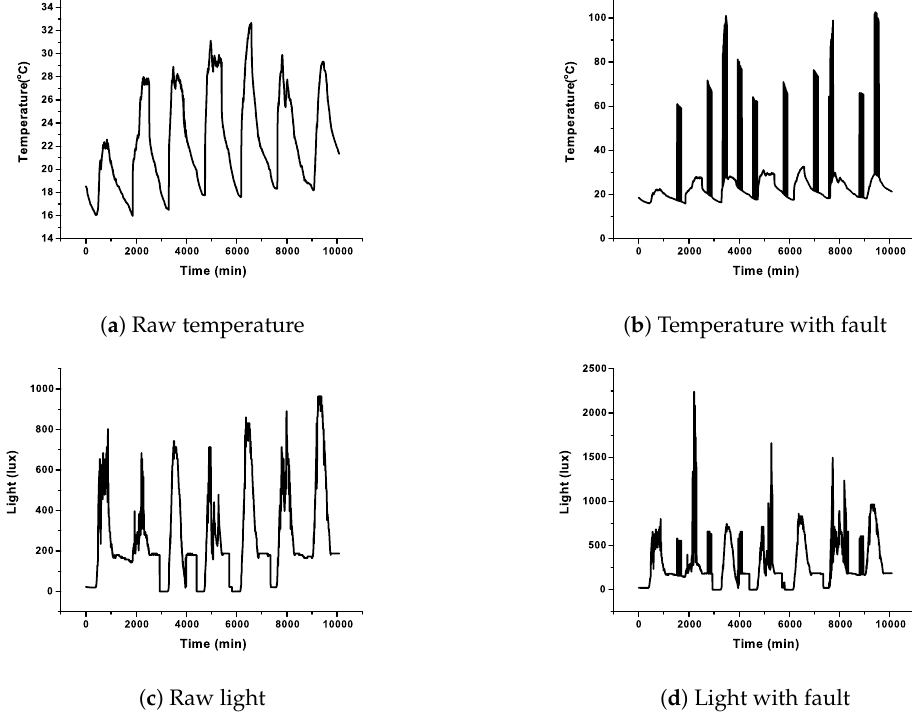
Figure 6. Temperature and light data with and without